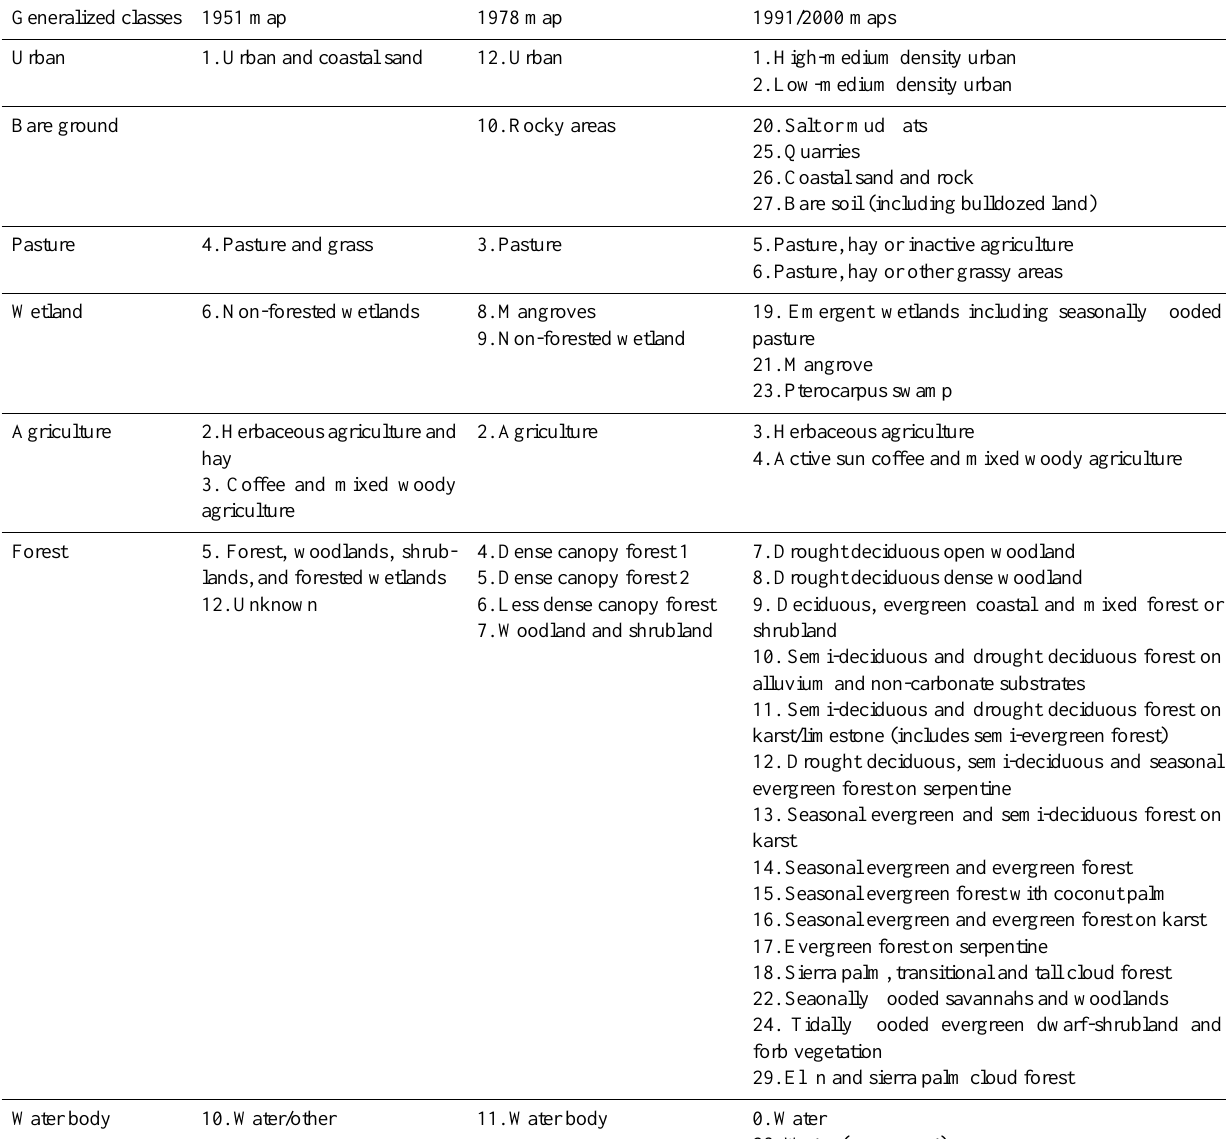
Table 2. Generalized land-cover classes as used here and their relation to the specific land-cover classes distinguished in the 1951, 1978, and 1991/2000 land-cover maps. The numbers correspond to the values for the classes used in the original land-cover